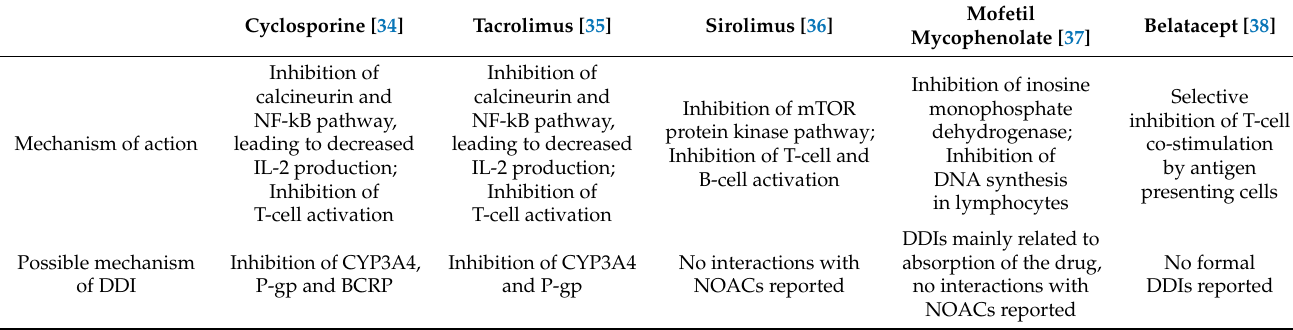
Table 2. Mechanism of action and possible mechanism for DDIs in immunosuppressive